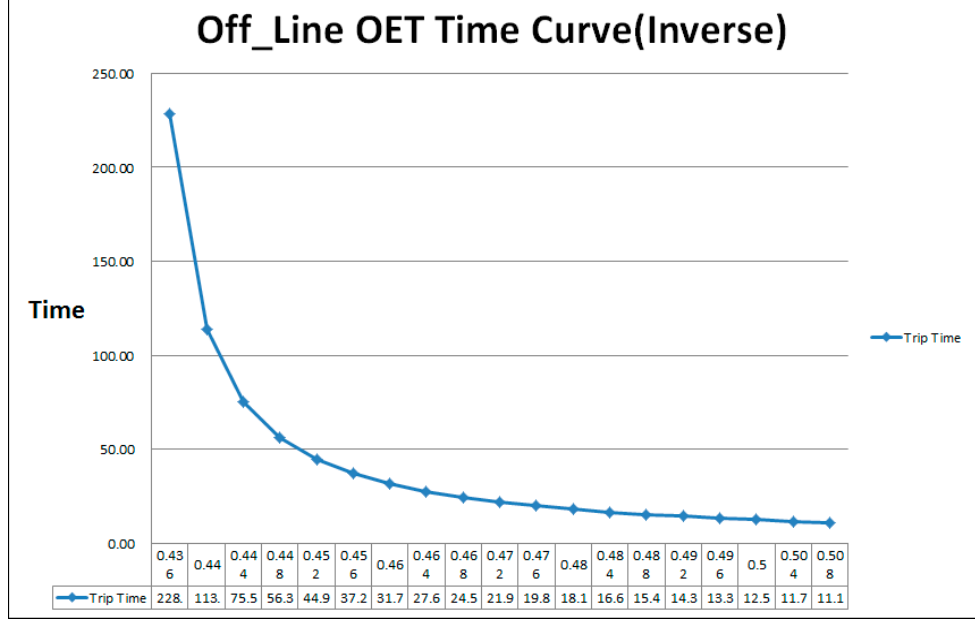
Figure 21. Over excitation trip time curve.